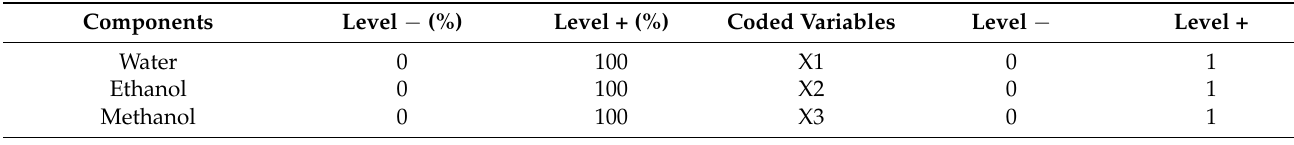
Table 1. Identification of solvent system factors.